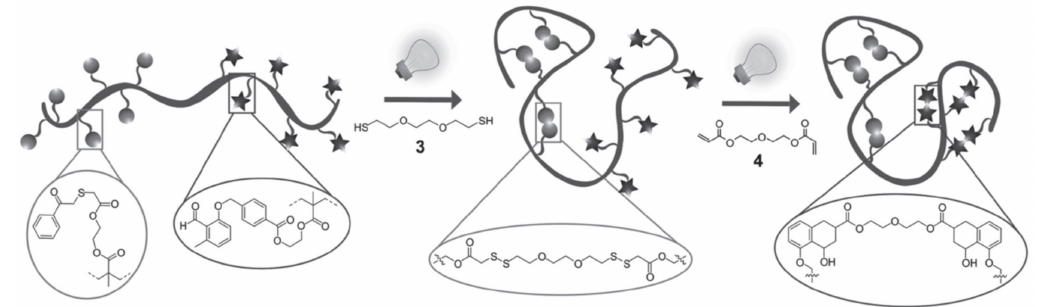
Figure 18. Schematic illustration of the sequential photoactivated multifolding of a precursor containing phenacyl sulfide and protected α -methylbenzaldehyde units with a dithiol cross-linker ( λ = 355 nm, 30 min) and a diacrylate cross-linker ( λ = 320 nm, 30 min), respectively. Reprinted from [57] with